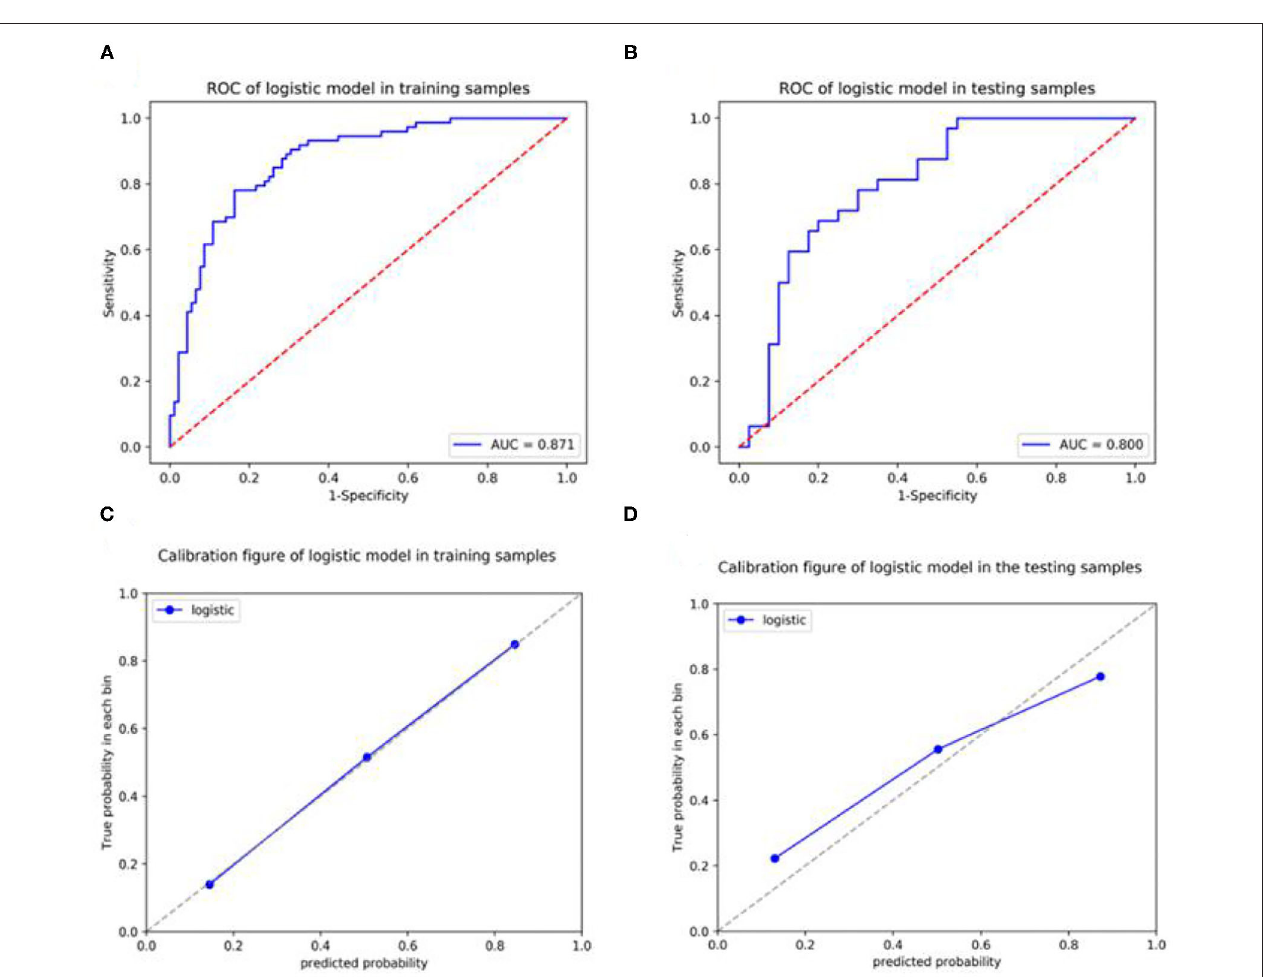
FIGURE 6 | Receiver operating curves ( ROCs) and a calibration curve analysis for the radiomic signature for predicting the expression level of Ki-67 in the training set and testing set. [ (A,C) training dataset, (B,D) testing dataset]. Calibration curves depict the calibration of each model in terms of the agreement between the predicted and actual probability of the positive Ki-67 expression level rate. The Y-axis represents the actual rate. The X-axis represents the predicted probability. The diagonal dotted line represents perfect prediction by an ideal model. The blue line represents the performance of the radiomic prediction model, of which a closer fit to the diagonal blue dotted line represents a better